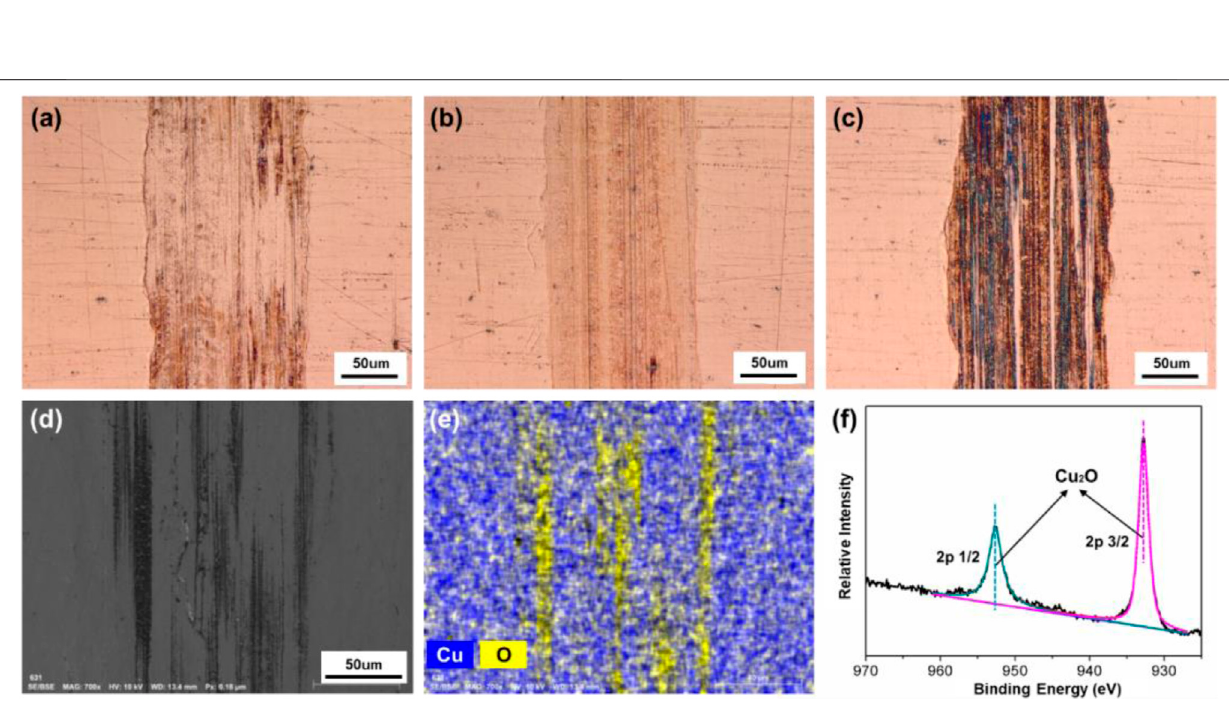
Frontiers in Chemistry |